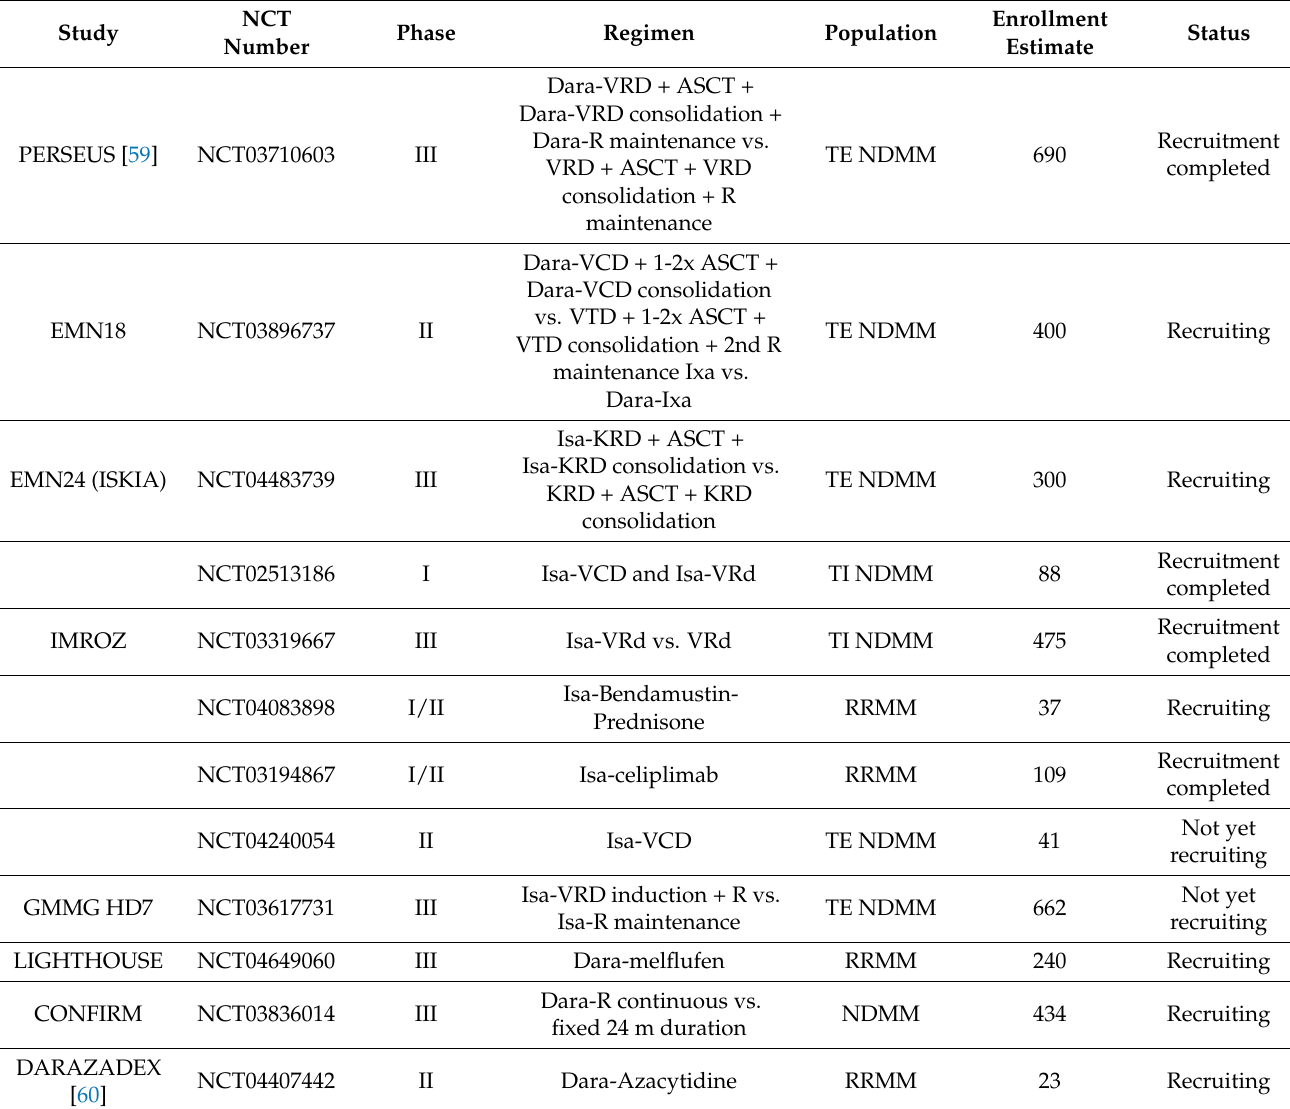
Table 4. Selection of ongoing trials with regimens containing